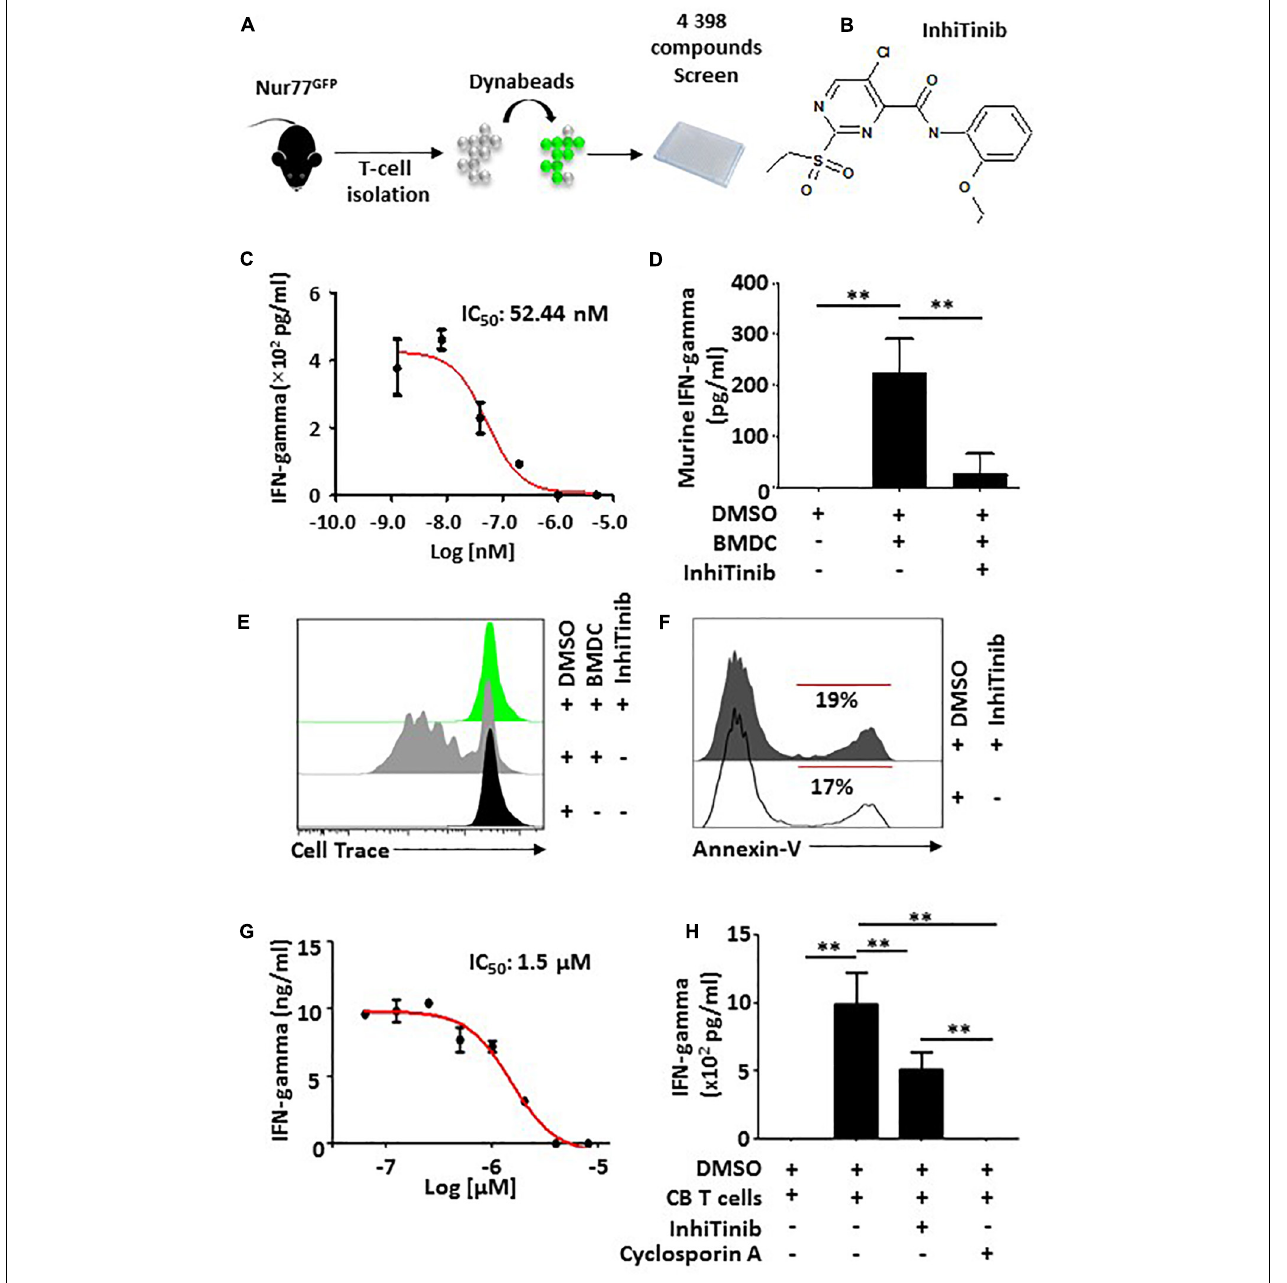
FIGURE 1 | InhiTinib impairs T cell activation without inducing apoptosis. (A) Schematic diagram representing the experimental design undertook to identify InhiTinib. (B) Chemical structure of InhiTinib. (C) Identification of the IC 50 dose for InhiTinib through assessment of IFN-gamma secretion by primary CD3 + T cells activated using CD3-CD28 dynabeads. (D) Quantification of IFN-gamma secretion by murine T cells cultured in a one-way MLR using allogeneic BMDCs. (E) Evaluating CellTraceTM dilution by T cells 48 h following a one-way MLR. (F) Representative flow-cytometry assessment of Annexin-V on dynabeads-activated T cells treated with InhiTinib (IC 100 ) vs. an equivalent volume of DMSO. (G) Identification of the IC 50 dose for InhiTinib through assessment of IFN-gamma secretion by CB-derived primary human CD3 + T cells activated using CD3-CD28 dynabeads ( n = 5/group). (H) Comparing the potency of InhiTinib to Cyclosporin A following dynabeads activation of CB-derived CD3 + T cells. Cyclosporin A was used at the same IC 50 dose of InhiTinib (1.5 µ M). For panels C,H , n = 5/group with ∗∗ P <